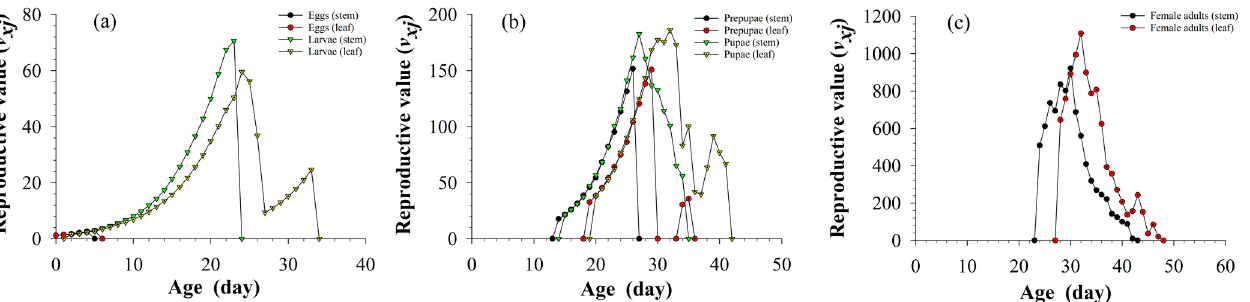
Figure 3. Age-stage-specific life expectancy ( e xj ) of eggs and larvae ( a ), prepupae and pupae ( b ), female adults and male adults ( c ) of S. litura fed on different tissues of asparagus.